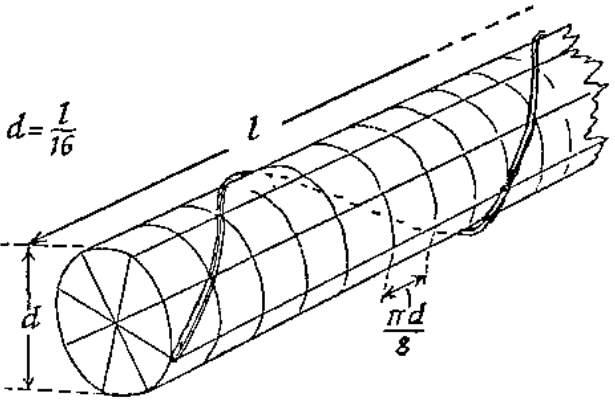
Figure 9. Design of the endless screw of Archimedes based on the description of Vitruvius (adapted from